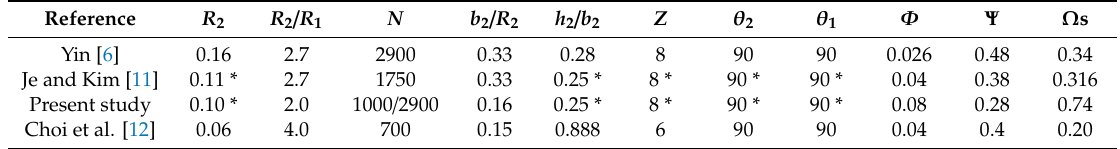
Figure 9. Theoretical head coefficient versus flow coefficient for four different rotational speeds (purple diamond symbols are extracted from the results published by Yin [6] for 2900 rpm).